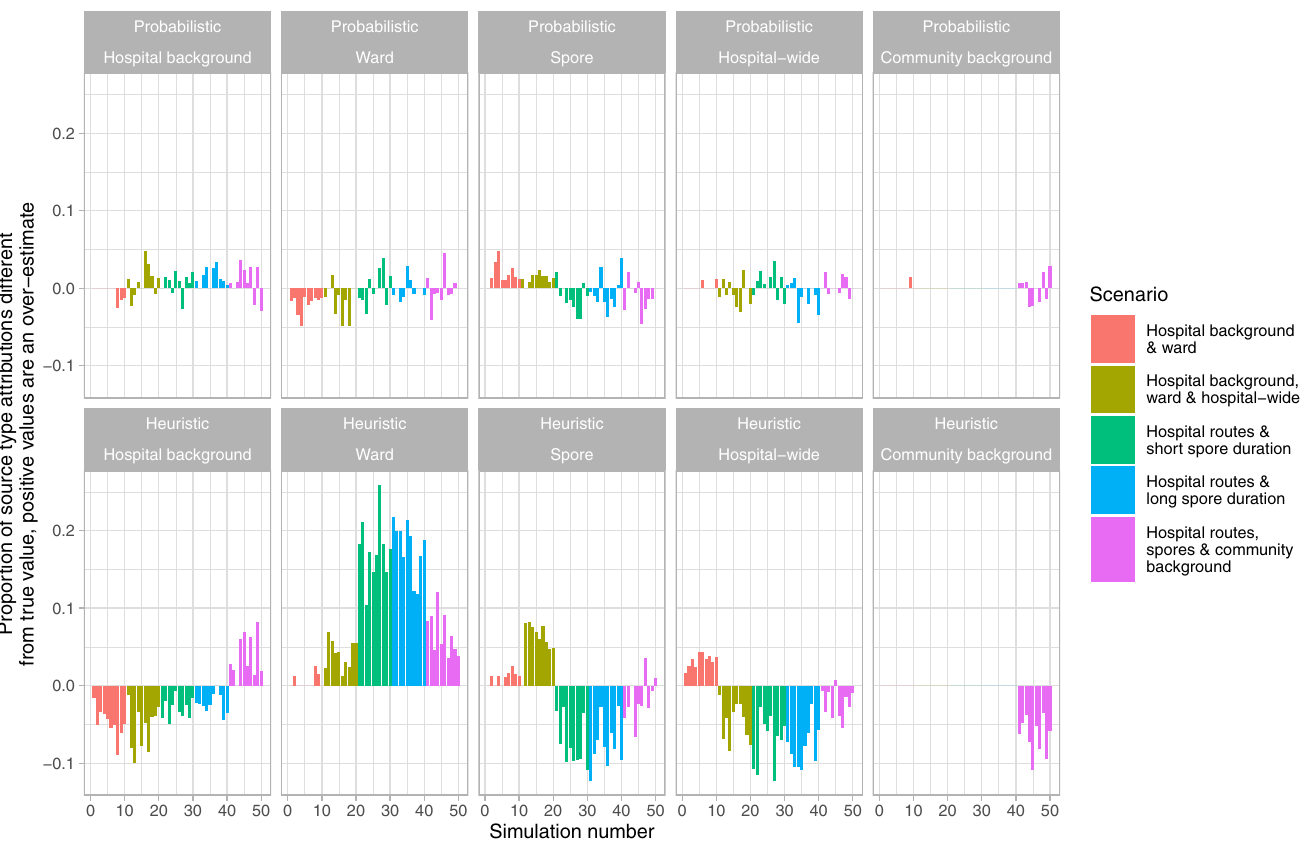
Fig 4. Comparison of source type attribution using a stochastic transmission model and heuristic rules.